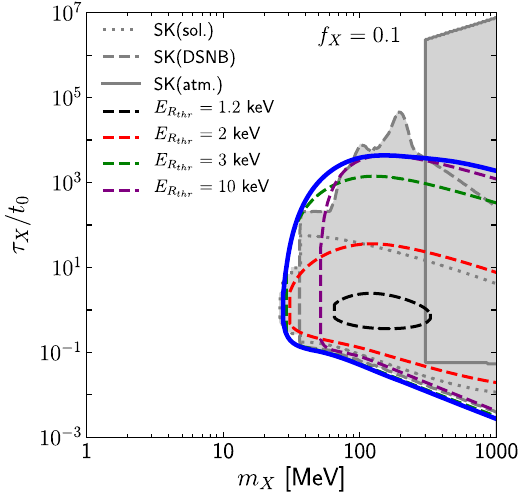
Fig. 3 Obtainable exclusion limits, for DR in form of SM neutrinos (baryonic neutrinos) in the left (right) panel, assuming f X = 0 . 1. The various dashed curves assume different nuclear recoil energies as